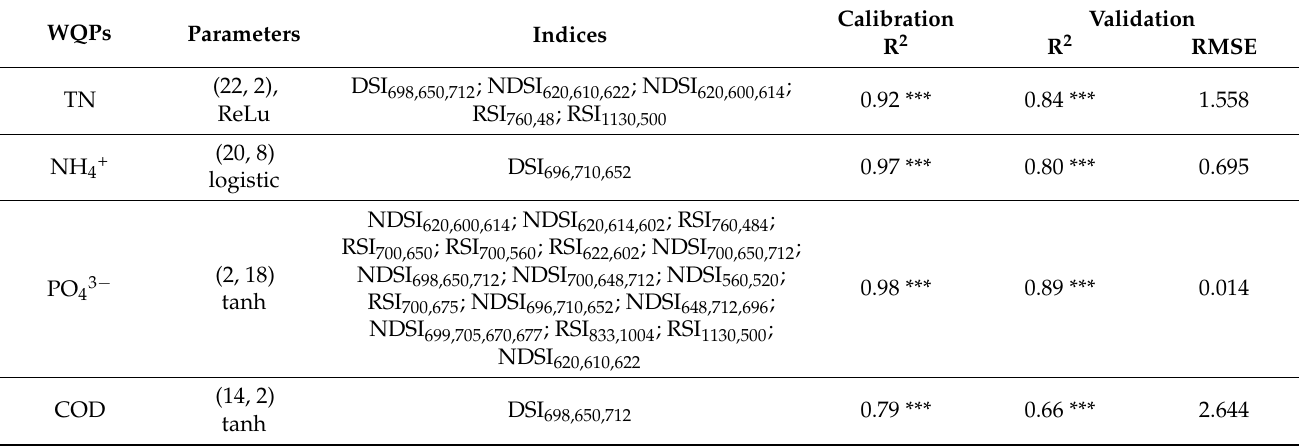
Figure 6. Neural network diagrams for this study, including total nitrogen (TN), ammonium (NH 4+ ), orthophosphate (PO 43 − ), and chemical oxygen demand (COD). Table 7. Results of calibration and validation models of artificial neural networks of the association between spec- tral reflectance indices and total nitrogen (TN), ammonium (NH 4+ ), orthophosphate (PO 43 − ), and chemical oxygen demand